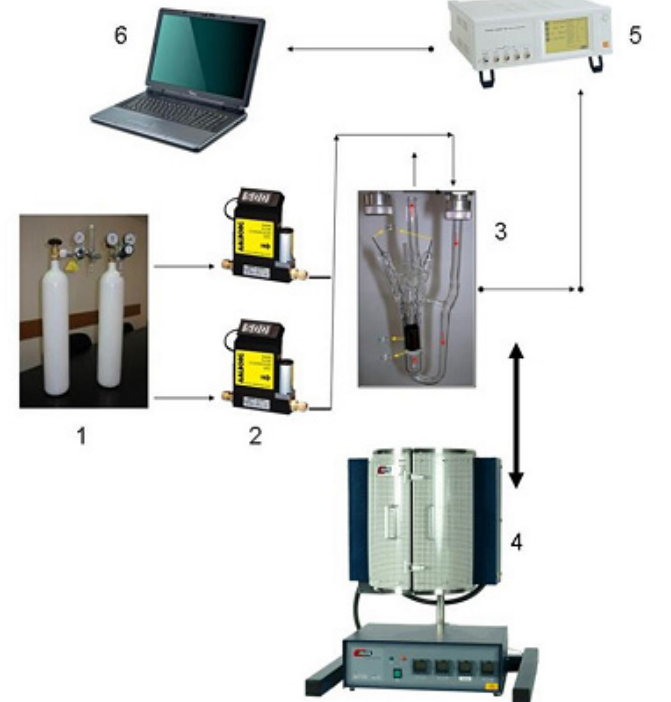
Figure 5. Gas-sensing experimental setup used for powder-type sensitive samples, with (1) carrier and target gas cylinders, (2) MFC system, (3) gas sensing cell, (4) programmable furnace, (5) RLC bridge, (6) data acquisition computer, from ref. [8].